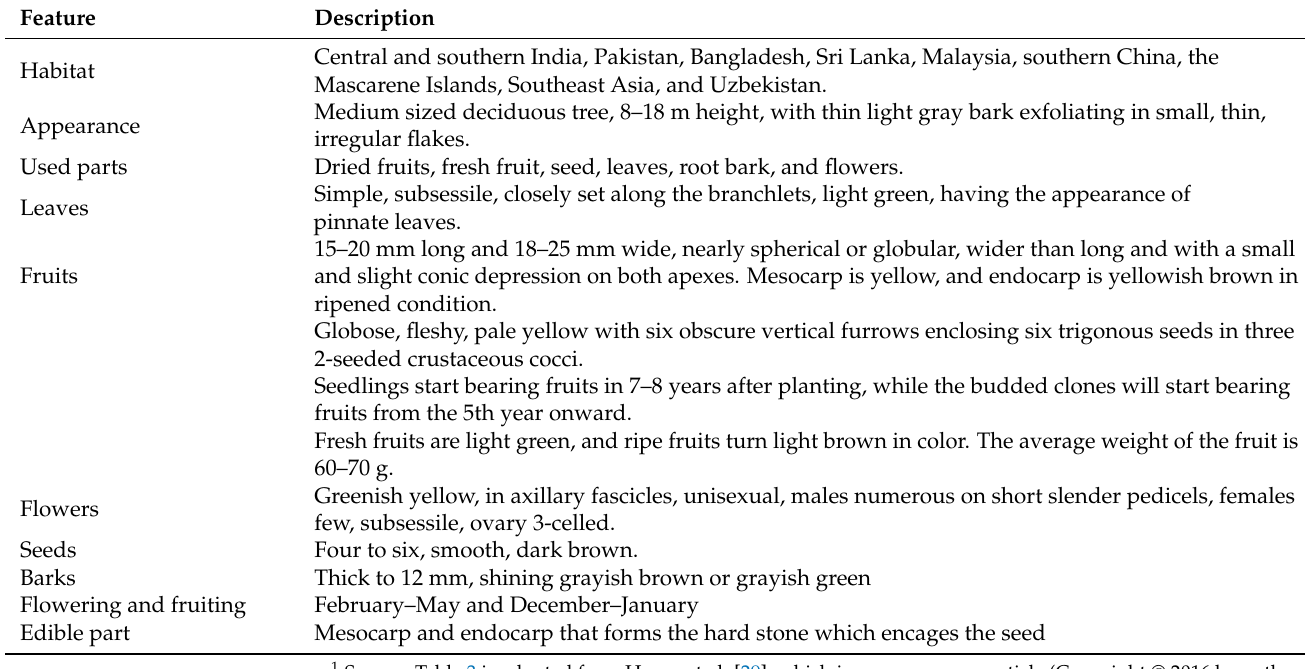
Table 3. Botanical description of E. officinalis 1 .